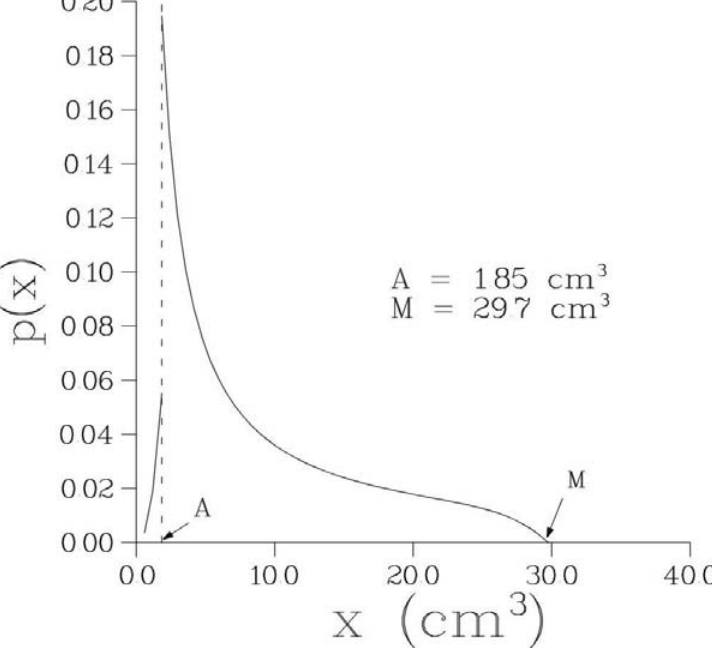
Figure 3. The probability density function, p(x), underlying the distribution of the volumes of detectable bone metastases, see Equations (13)-(16), for patient 1. Note the jump discontinuity at point A = 1.85 cm 3 where p(A+)/p(A- ) = γ represents the volume of a metastasis whose inception occurred at the time of surgery while M is the maximum possible volume of bone metastases, that is, the volume of a metastasis whose inception occurred at onset of the primary tumor.